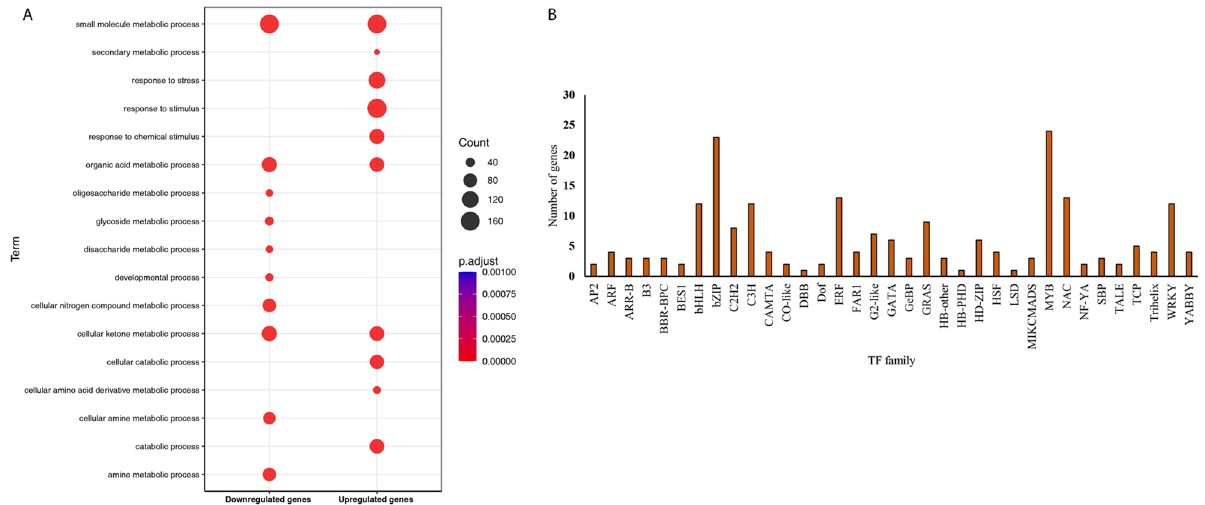
Figure 3. ( A ) Top 10 gene ontology biological processes (GO-BP) terms of the up-regulated and the down regulated differentially expressed genes (DEGs). ( B ) Distribution of transcription factor (TF) families in the differentially expressed genes (DEGs). The number of genes is shown for each transcription factor family on the y-axis.